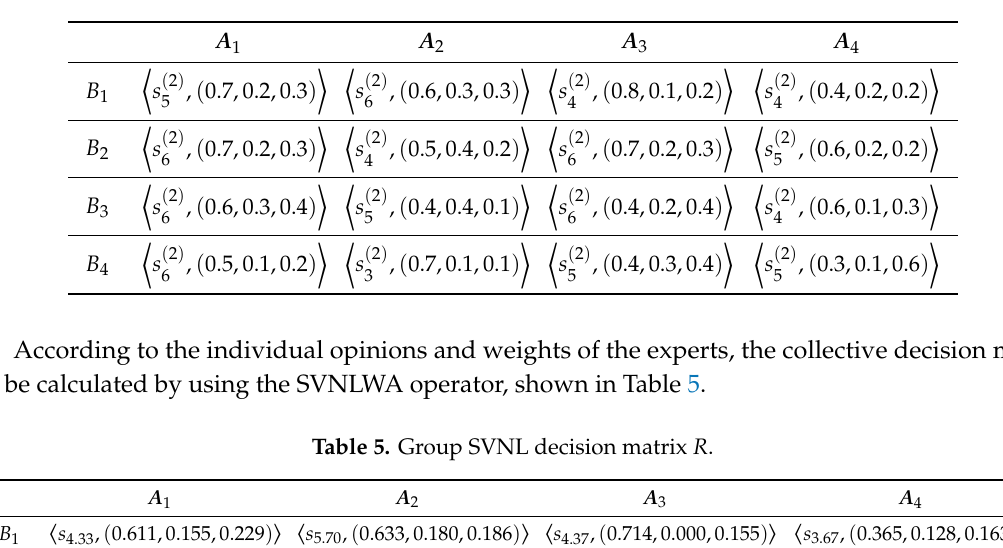
Table 4. SVNL decision matrix R 3 .